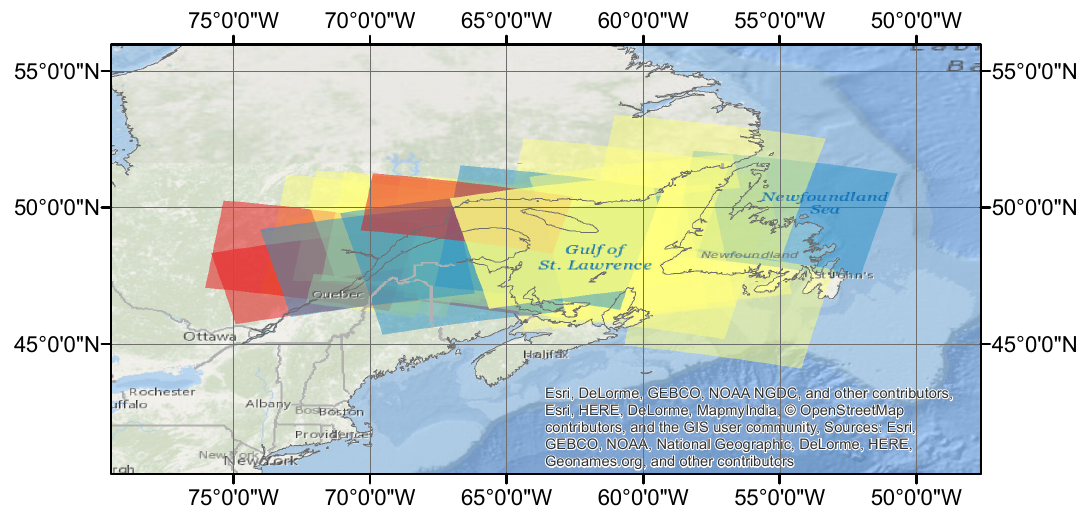
Figure 1. Study area and the dataset for the Gulf of Saint Lawrence. There are 25 scenes of dual-pol SAR images acquired between 16 January 2014 and 10 February 2014 in this area. The coverage for each scene is marked in a translucent polygon with different colors. Yellow scenes are used for training, red are used for validation and blue for